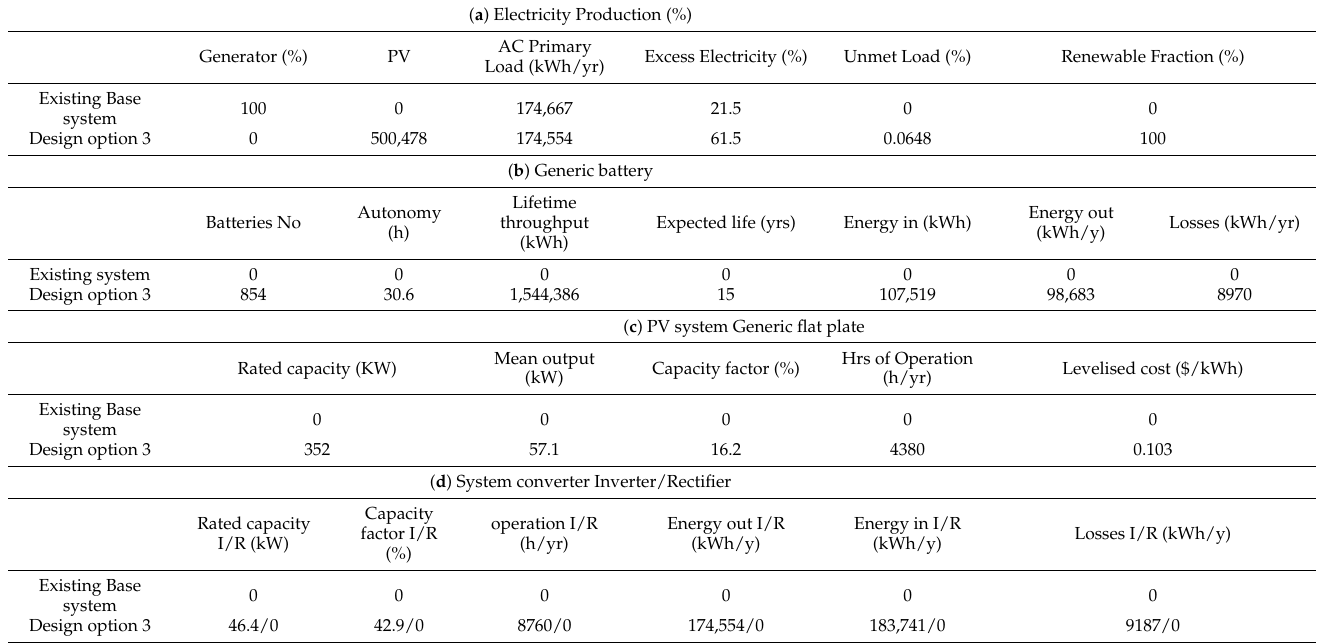
Table 9. ( a – d ): Design option 3 comparing technical parameters of the base system and proposed hybrid system of simulated values.